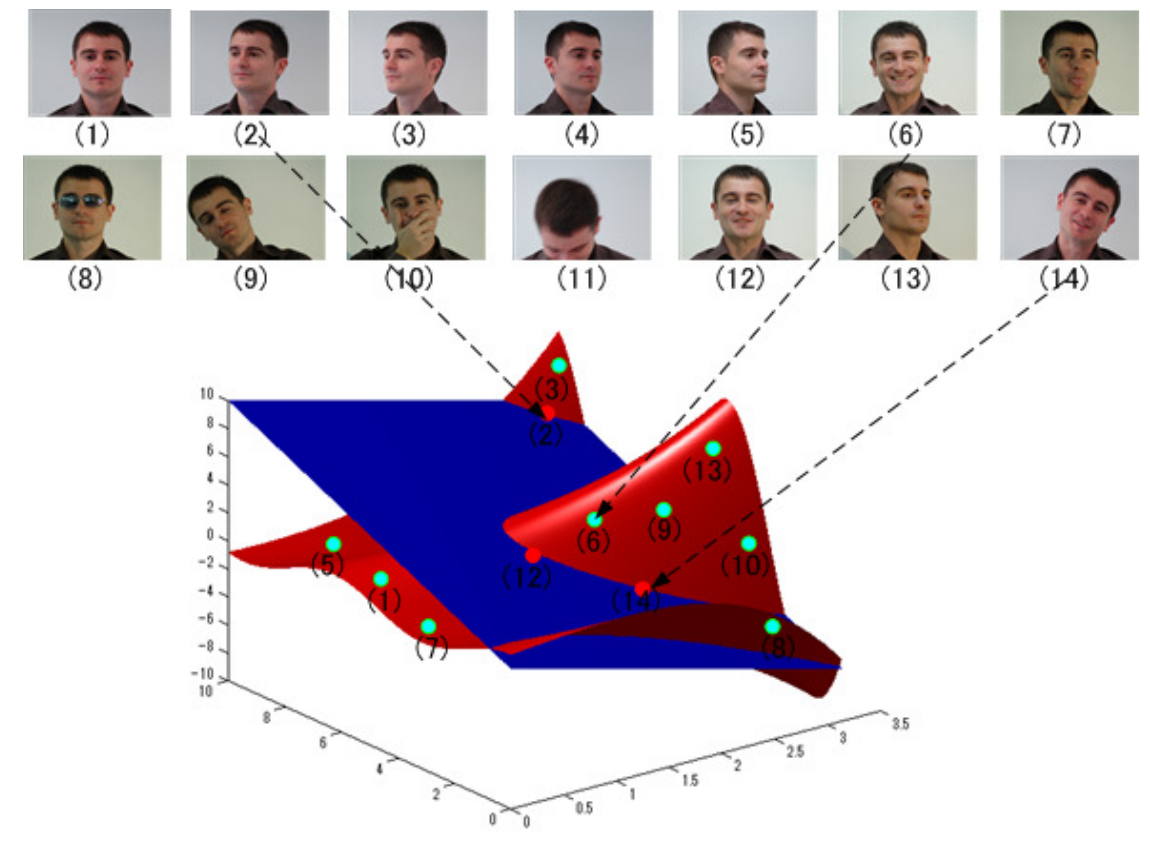
Figure 1. The demonstration of two manifold surfaces: The red one represents a full face space projected from all of the samples of one person; and the blue one is a face space learned when only three samples are